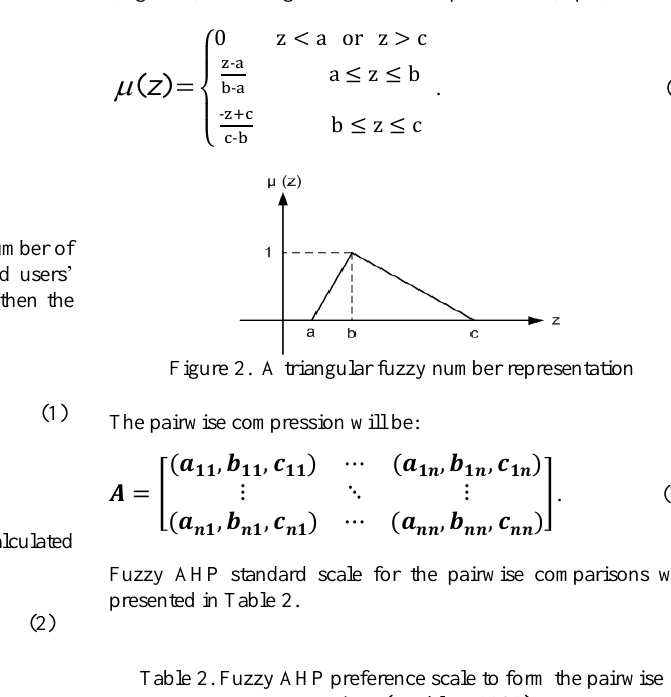
Each triangular fuzzy number has a linear representation (Figure 2) according to its membership function (Eq. 6).